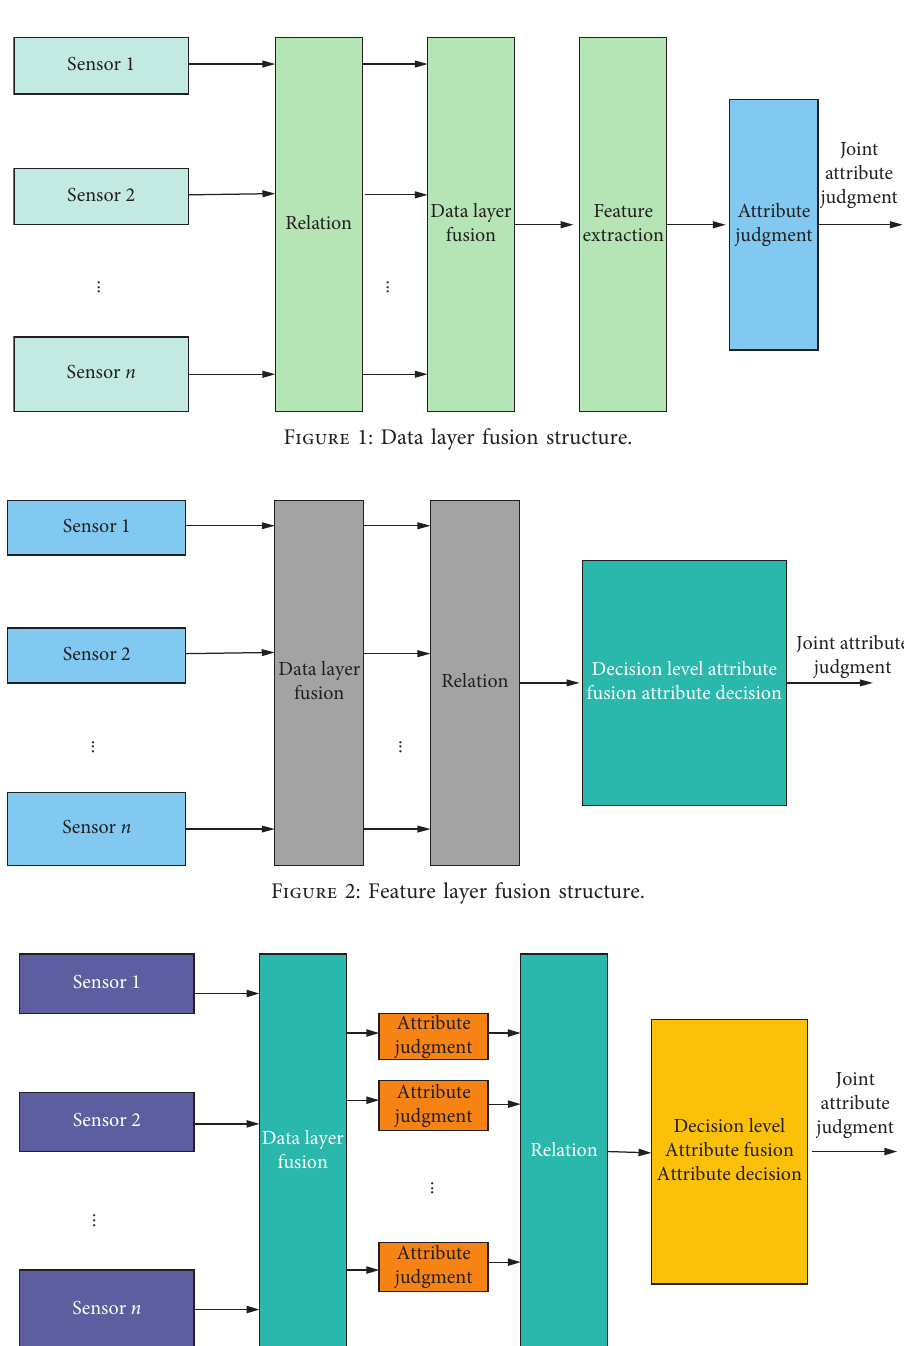
Figure 3: Decision-level fusion structure.